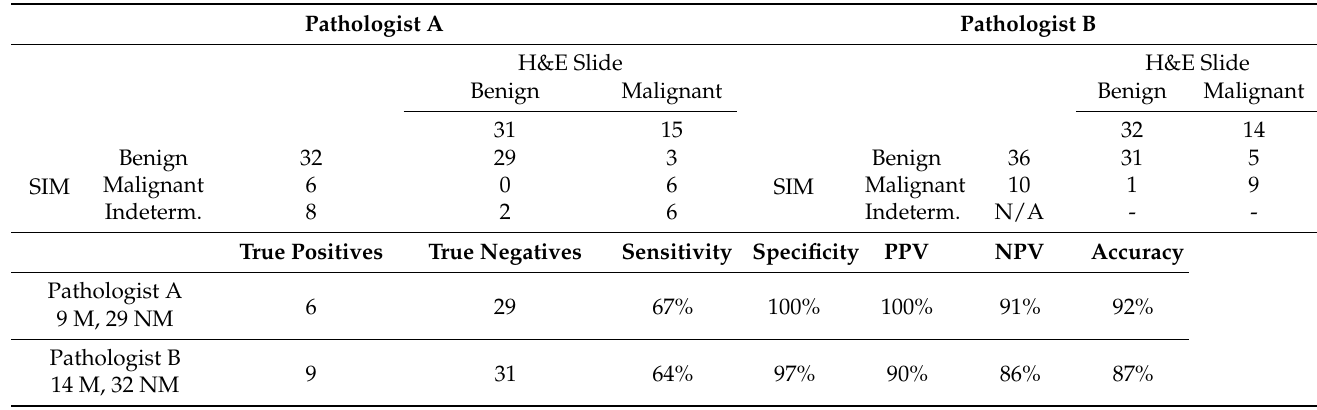
Table 1. Confusion matrices for both pathologist raters and diagnostic results summary of SIM images against gold-standard histopathology slides. Positive predictive value is abbreviated PPV and negative predictive value is abbreviated NPV in this table. M stands for malignant and NM stands for